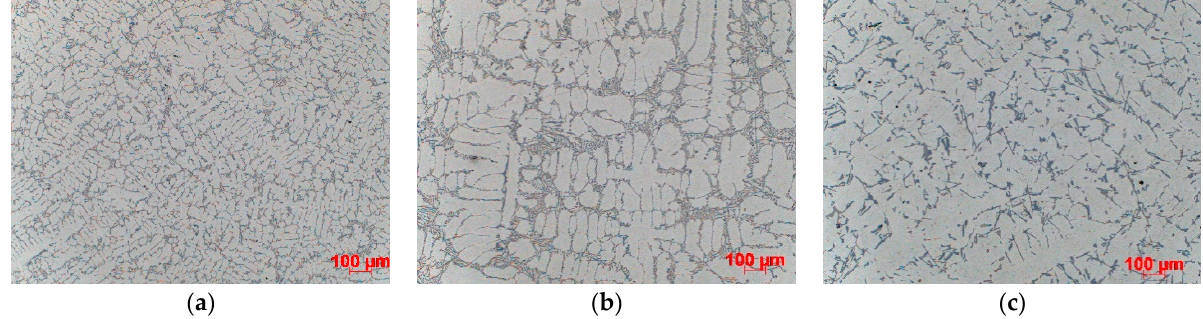
Figure 6. Dispersion of dendritic structure in casting made in Sand No. 3, etched with HF, 100 × magnification: ( a ) die, ( b ) ablation, ( c ) sand mould.